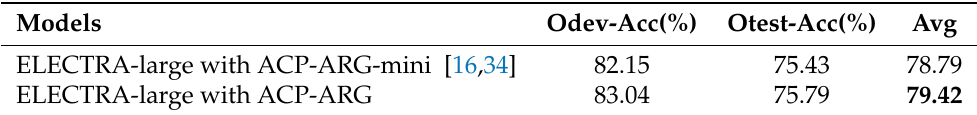
Table 5. Experiment with ELECTRA-large with full training set on the official test